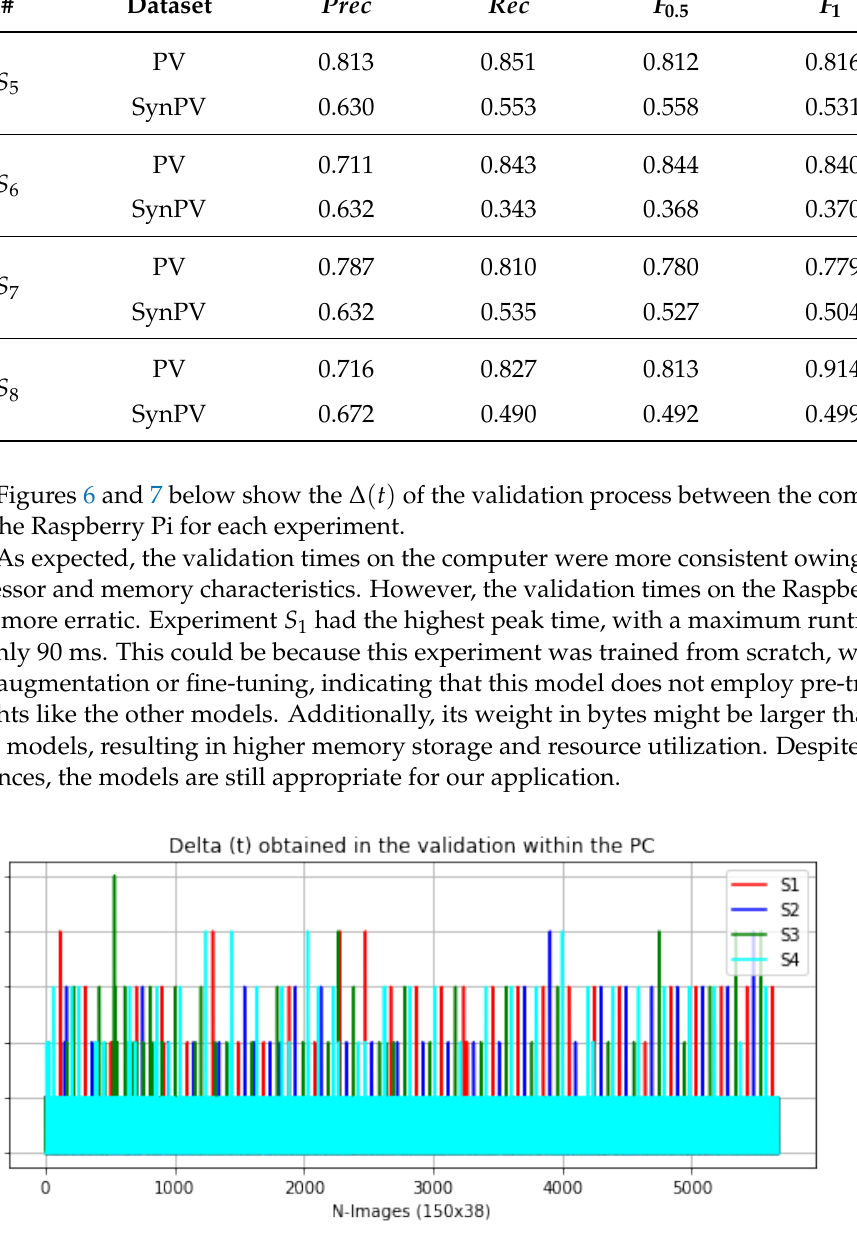
Figure 6. Delta (t) obtained in the validation within